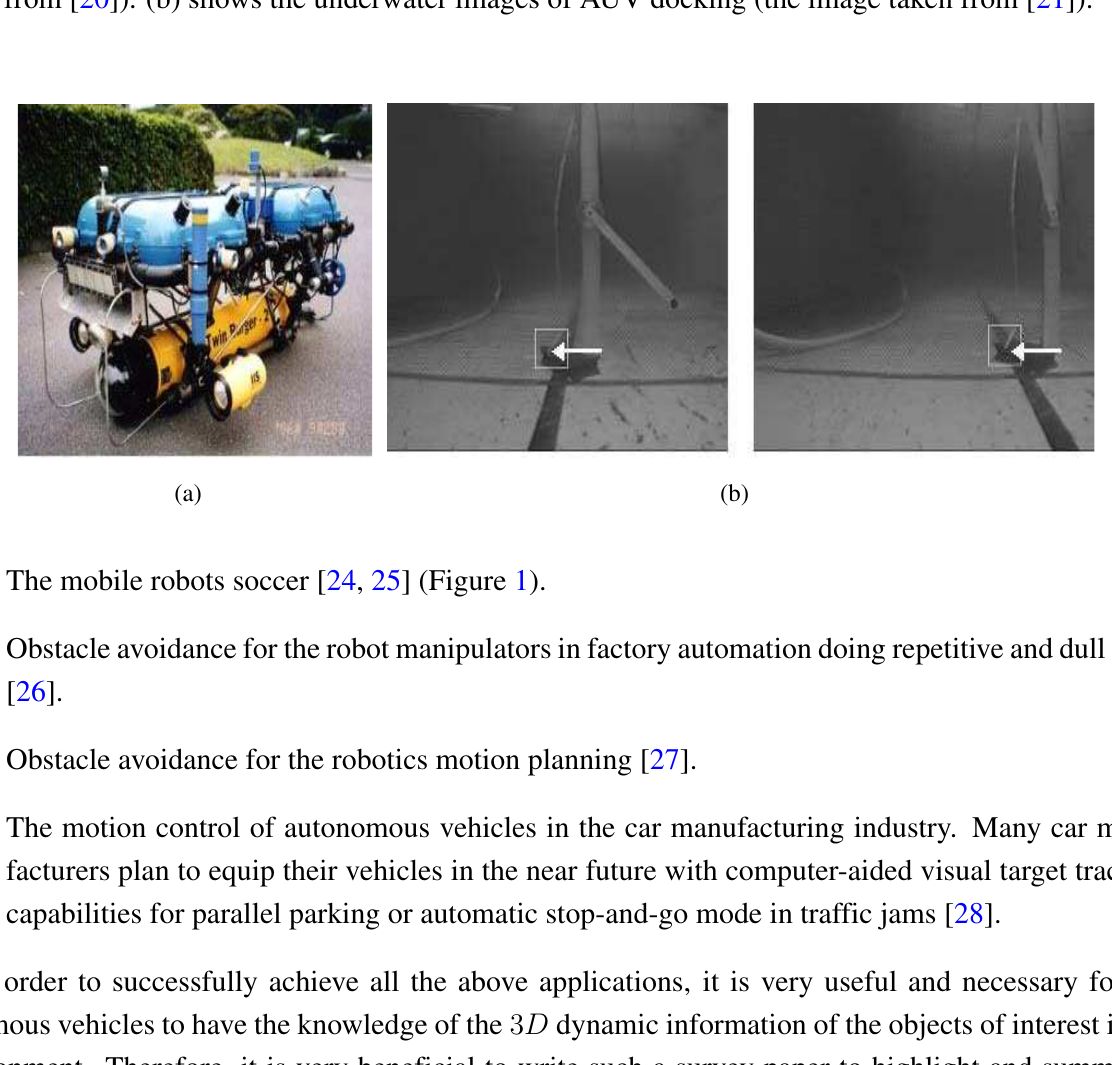
Figure 2. Some applications of the visual target tracking system for AUV navigation. (a) shows the test bed AUV (Twin-Burger 2 ) for the underwater cabal following (the image taken from [20]). (b) shows the underwater images of AUV docking (the image taken from